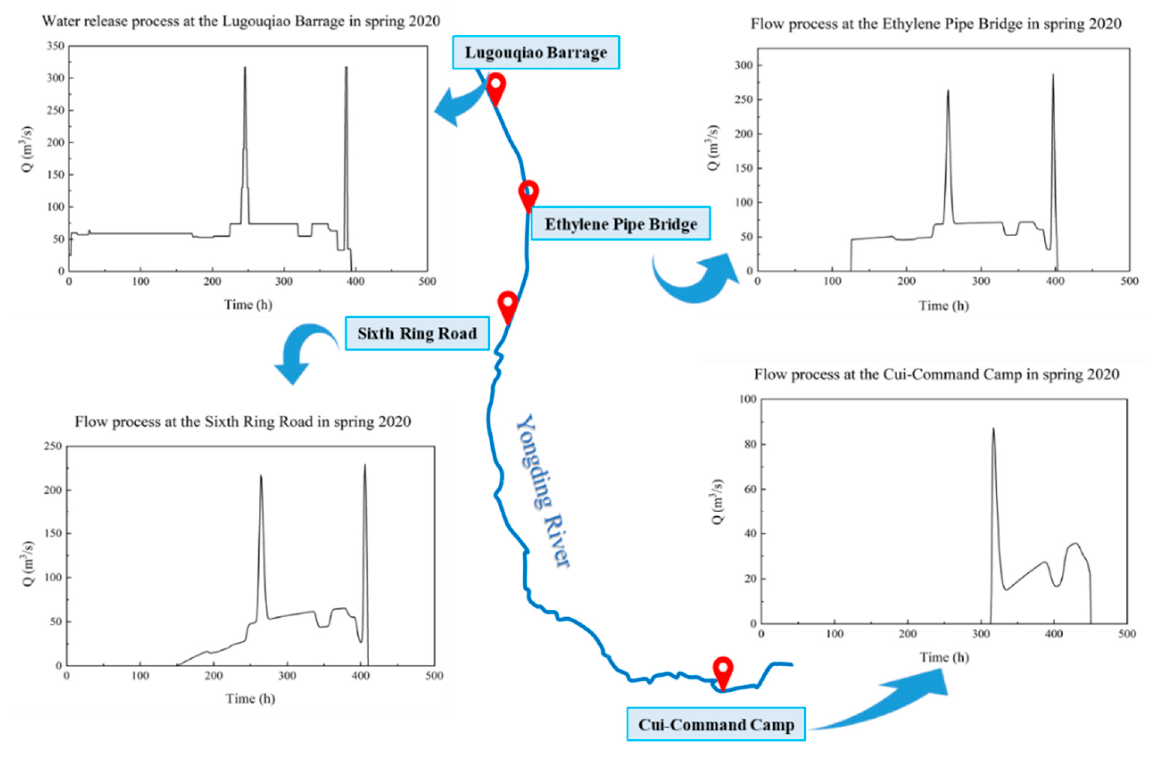
Figure 7. Flow process of typical sections in the southern plain reach of the Yongding River in spring 2020. Table 6. Leakage loss over